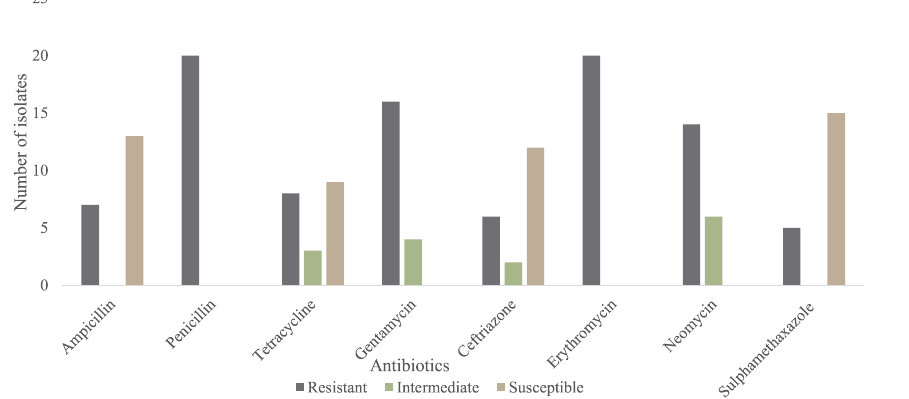
Fig. 1. Susceptibility patterns of E. coli isolates to the 8 antibiotics